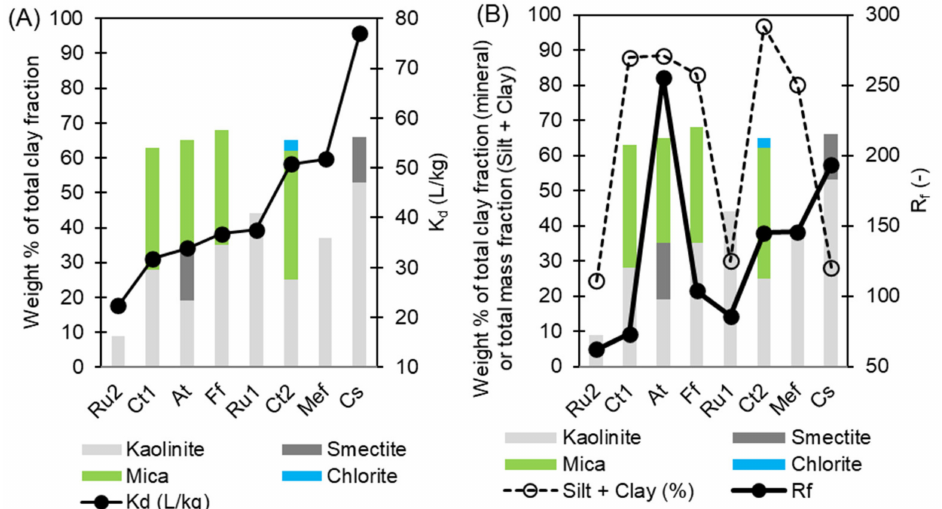
Figure 4. Water-dispersible clay-fraction mineral abundances and ( A ) linear isotherm coefficient ( K d ), and ( B ) retardation factor ( R f ) and silt and clay fraction (At, Alligator Association; Cs, channel sand; Ct1, Cuthbert Series A horizon; Ct2, Cuthbert Series B horizon; Ff, Falaya Silt Loam Series; MeF, Memphis Silt Loam Series; Ru1, Ruston Series A horizon; Ru2, Ruston Series E